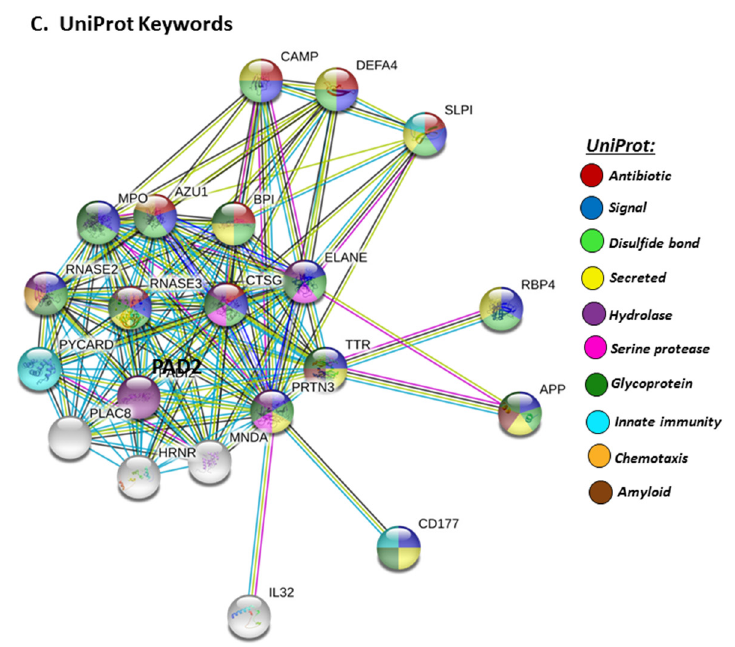
Figure 6. GO and Reactome pathway analysis for PAD2, highlighting immune related GO biological pathways ( A ) Immune related Reactome pathways ( B ) UniProt keywords ( C ) Colour code for the di ff erent pathways is shown within the figure. Individual coloured lines represent specific protein interactions that have been identified through interactions that are known (referring to experimentally determined connections and curated databases), through interactions that are predicted (referring to gene fusion, gene neighbourhood, gene co-occurrence) or through interactions identified via text mining, co-expression or protein homology (please refer to the colour key provided in the figure for the di ff erent connective lines) (PPI enrichment p -value: < 1.0 × 10 − 16 ).